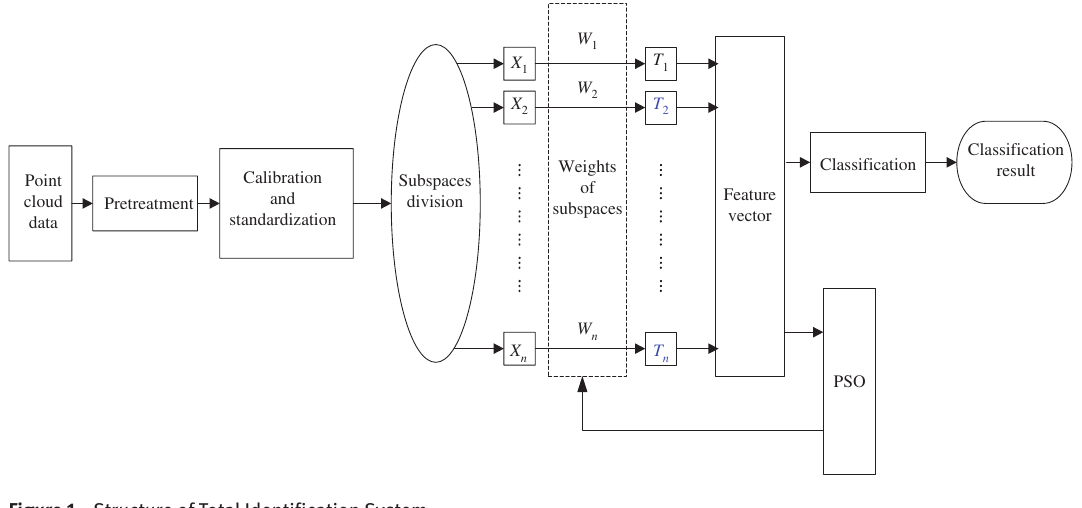
Figure 1: Structure of Total Identification